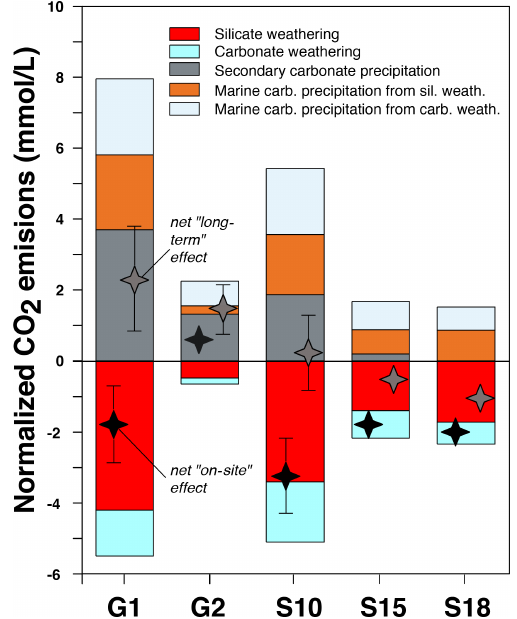
Figure 7. Evaluation of the effect of weathering processes at Séchilienne on atmospheric CO 2 . The hydrochemistry of the G1 and G2 springs draining the instability (the unstable zone) show that the weathering results in long-term CO 2 production to the at- mosphere because the cations are preferentially released in spring waters by the action of sulfuric acid and not carbonic acid from the soils (Table S3 in the Supplement). In the bedrock stable zone (spring S10) and in the mixed stable zone (springs S15 and S18), weathering processes act as CO 2 sinks or are CO 2 -neutral within uncertainty. Secondary carbonate precipitation returns CO 2 to the atmosphere. In particular, in the G2 spring of the unstable zone, this process results in a net “on-site” CO 2 release because it involves precipitation of Ca and alkalinity derived from carbonate weather- ing by sulfuric